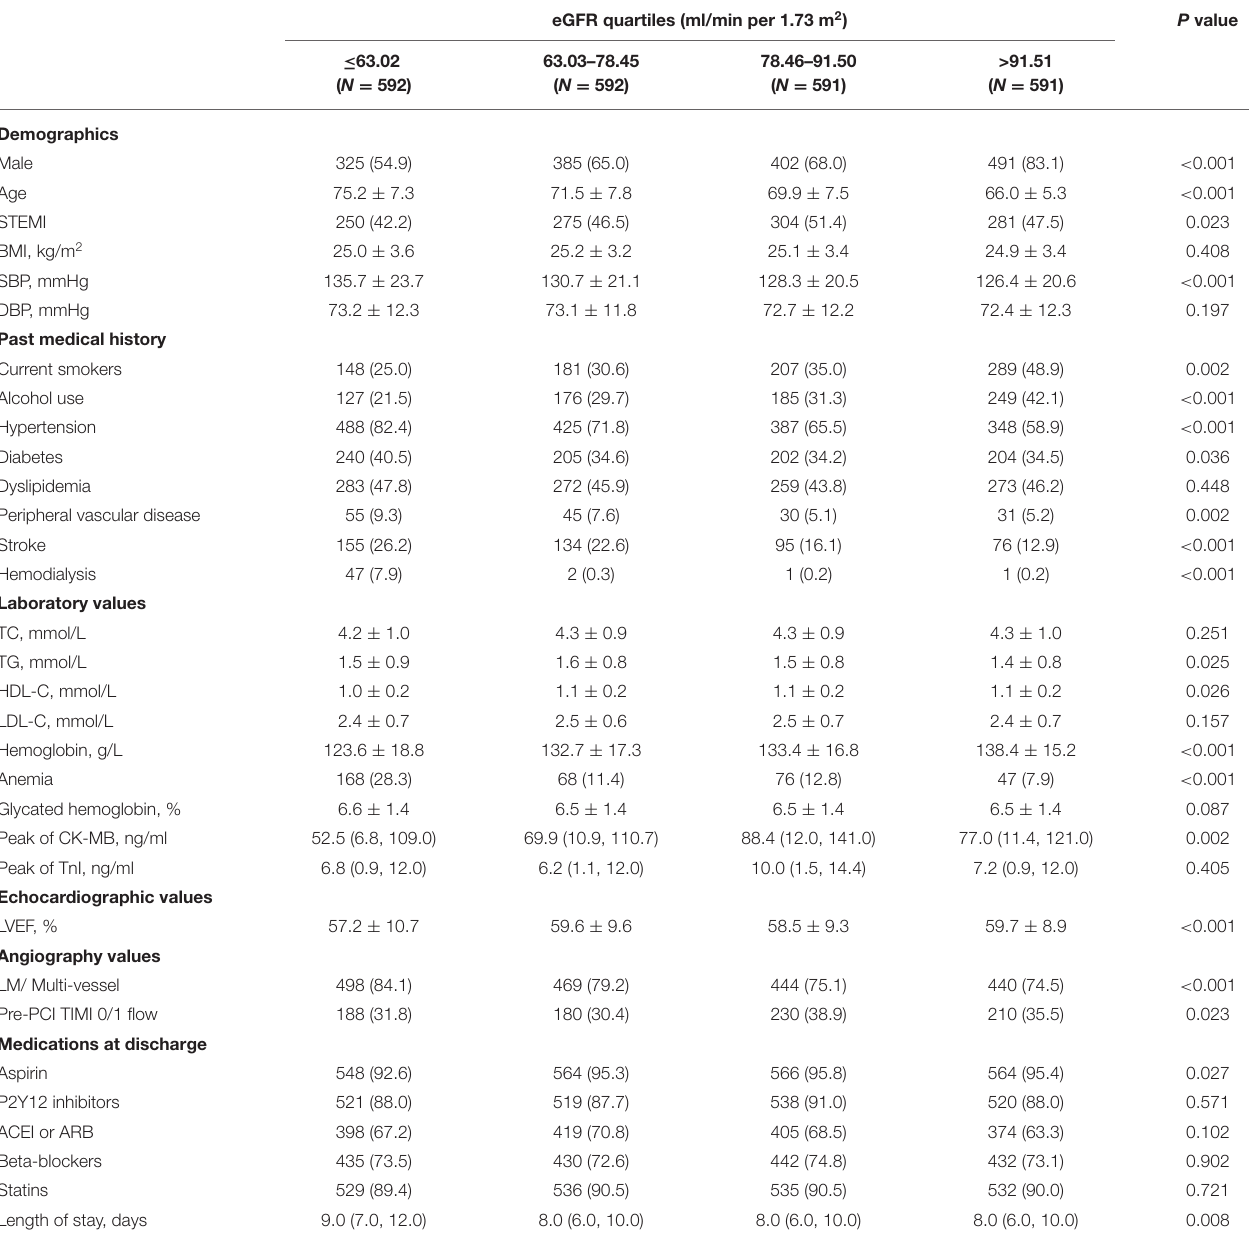
TABLE 1 | Baseline characteristics of the study